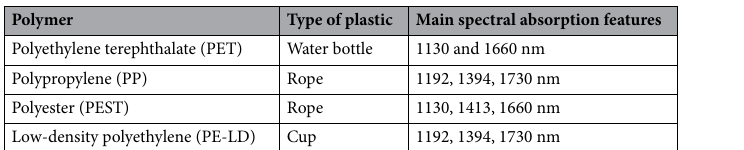
Table 1. Main absorption features of different